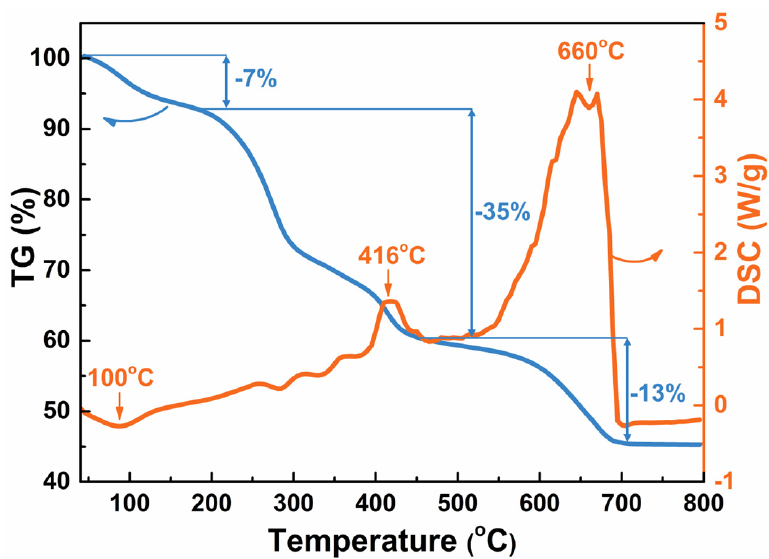
Figure 1. The TG and DSC curves of the BNT–5.5BZ dried gel powder heated from 40 ◦ C to 800 ◦ C. (The TG curve was shown by the blue line, and the DSC curve was marked by the orange line). The preparation of BNT–5.5BZ thin films was divided into two steps: spin–coating and annealing. All BNT–5.5BZ thin films were deposited on polycrystalline Pt/TiO 2 /SiO 2 /Si (001) substrates. First, span–coating proceeded at 3000 revolutions per minute for 40 s. A sin- gle wet gel layer was submitted to a heating process: 150 ◦ C for 3 min